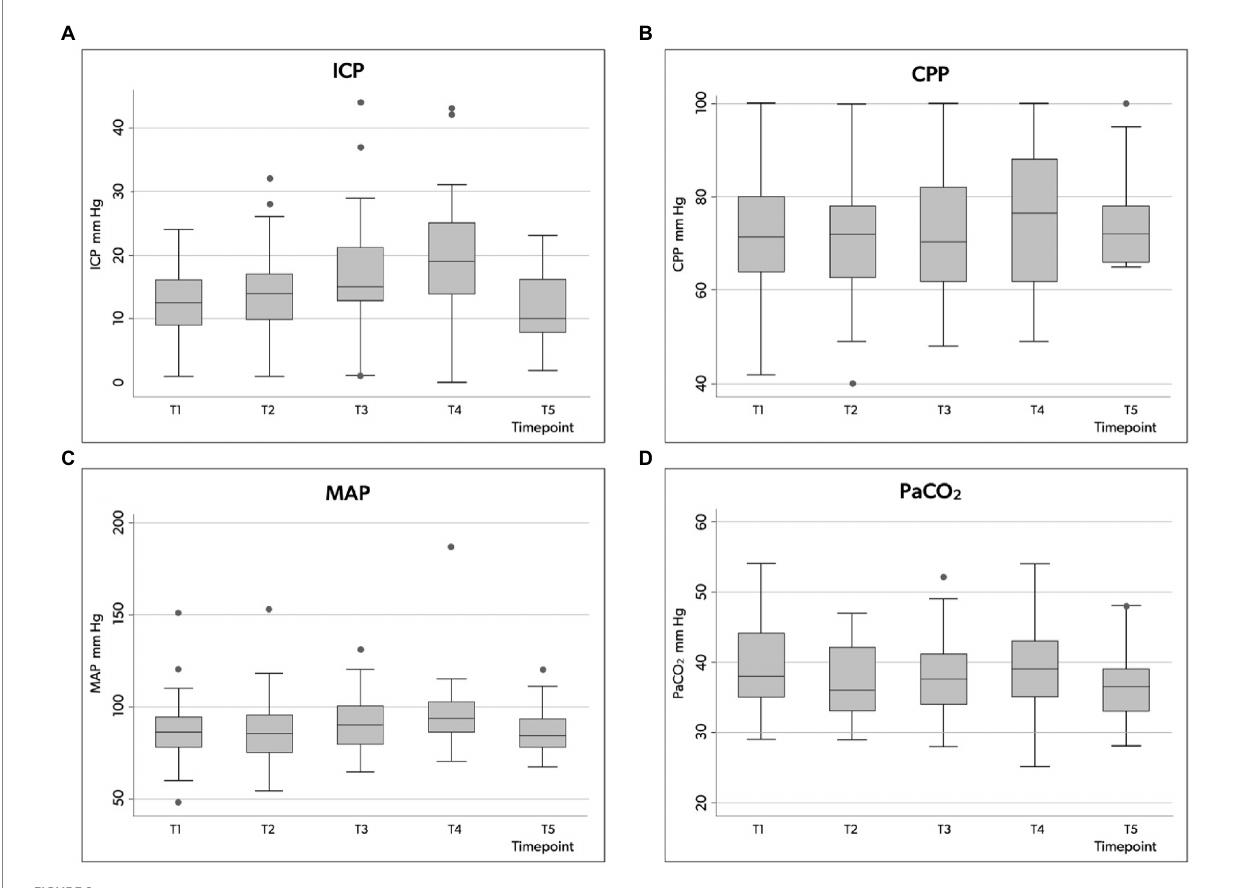
FIGURE 2 Box plots illustrating the distribution of ICP (A) , CPP (B) , MAP (C) and PaCO2 (D) values (minimum value, first quartile, median, third quartile, and maximum value) at the five time points in the whole group. ICP, intracranial pressure; CPP, cerebral perfusion pressure; MAP, mean arterial pressure; PaCO 2 , partial pressure of carbon dioxide in the arterial